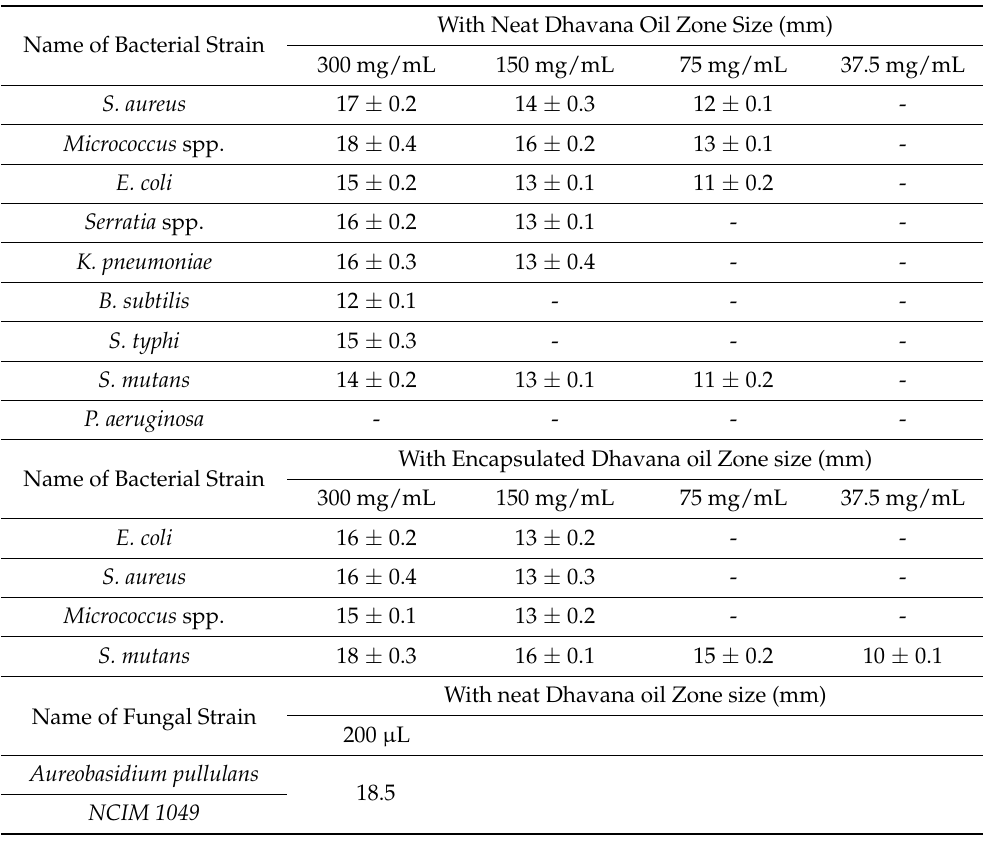
Table 10. Results of neat and encapsulated Dhavana oil against bacterial and fungal strains in the form of a zone of inhibition obtained (mm) are tabulated below. With Neat Dhavana Oil Zone Size Name of Bacterial Strain